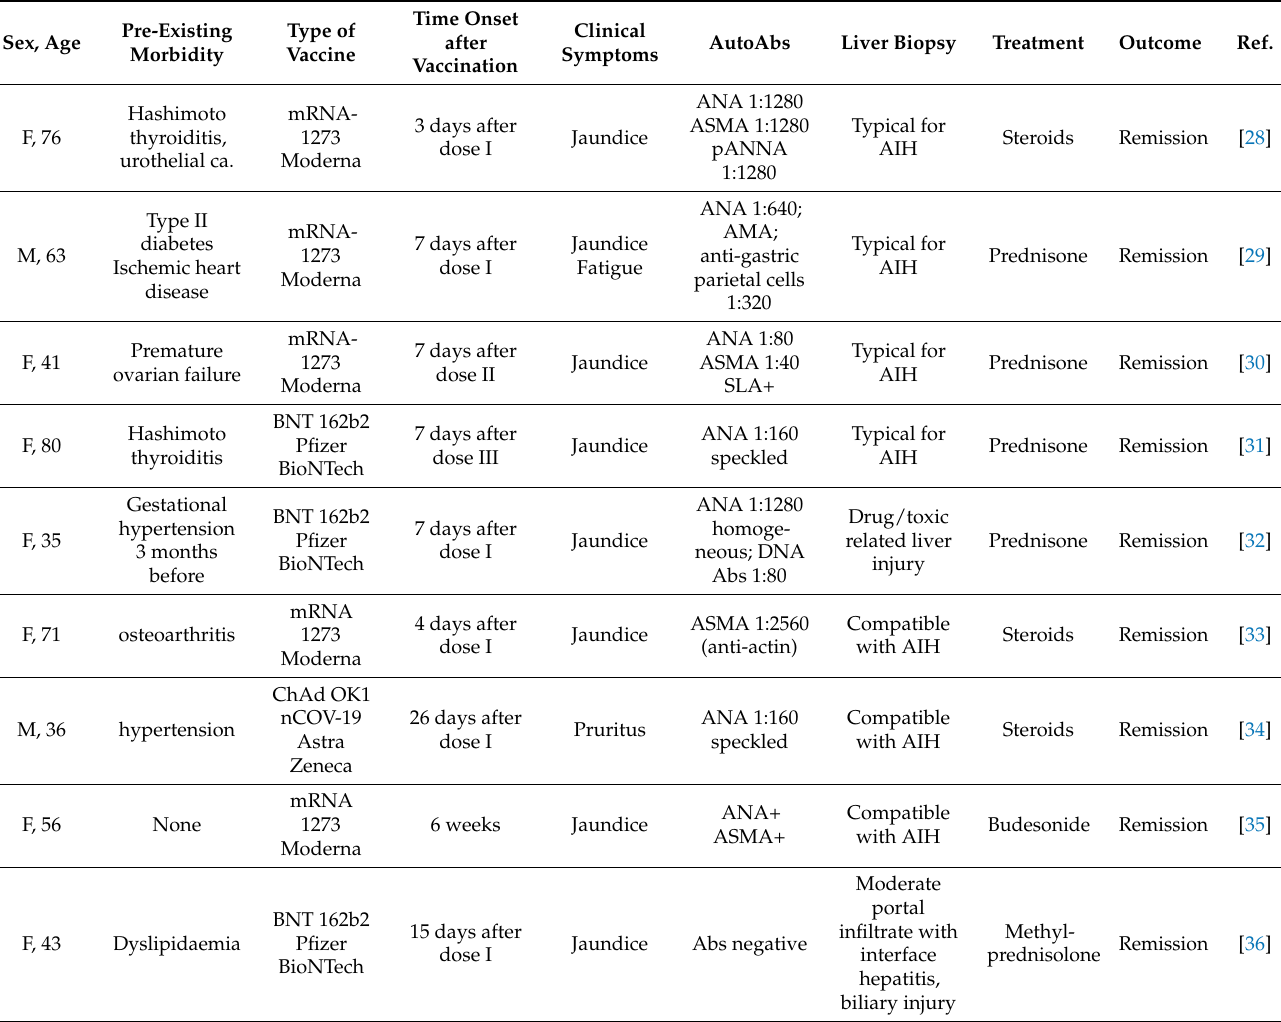
Table 1. AIH after SARS-CoV-2